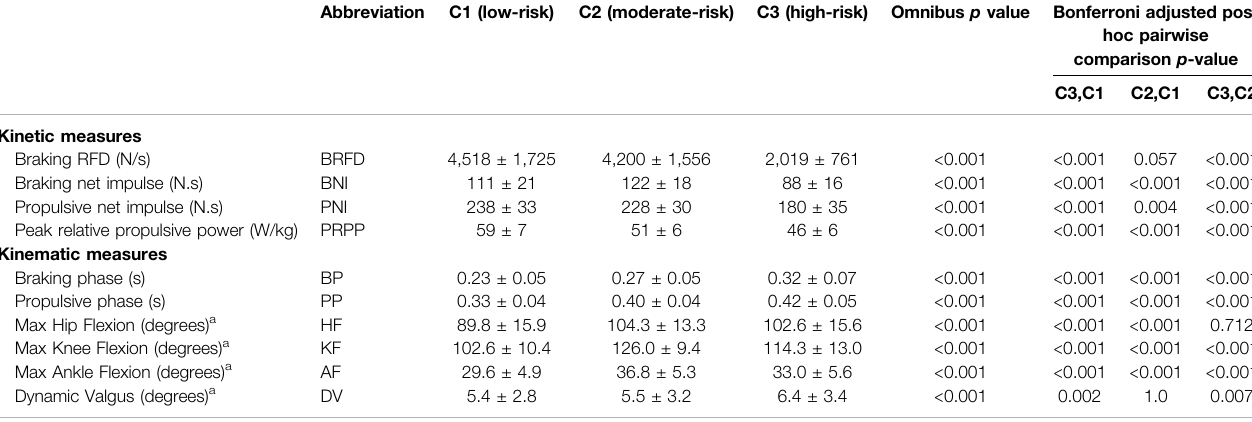
TABLE 6 | Markerless motion capture and force plate variables used for K-means clustering in Marine Of fi cer Candidates.